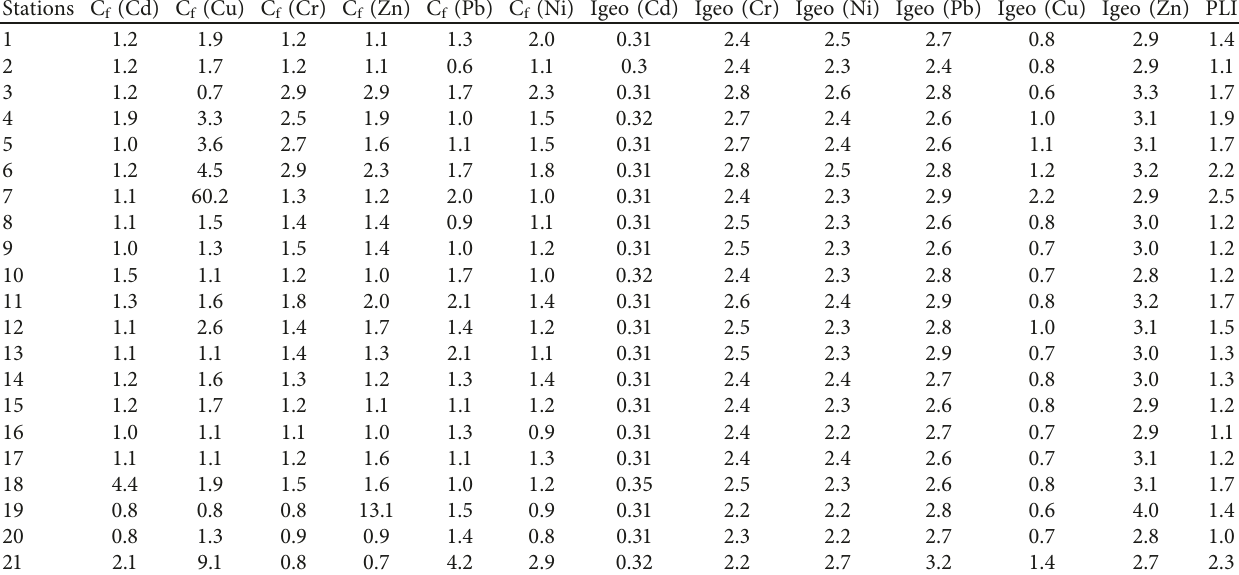
Table 6: Geoaccumulation index (Igeo), contamination factor (C Rades-Hamam Lif